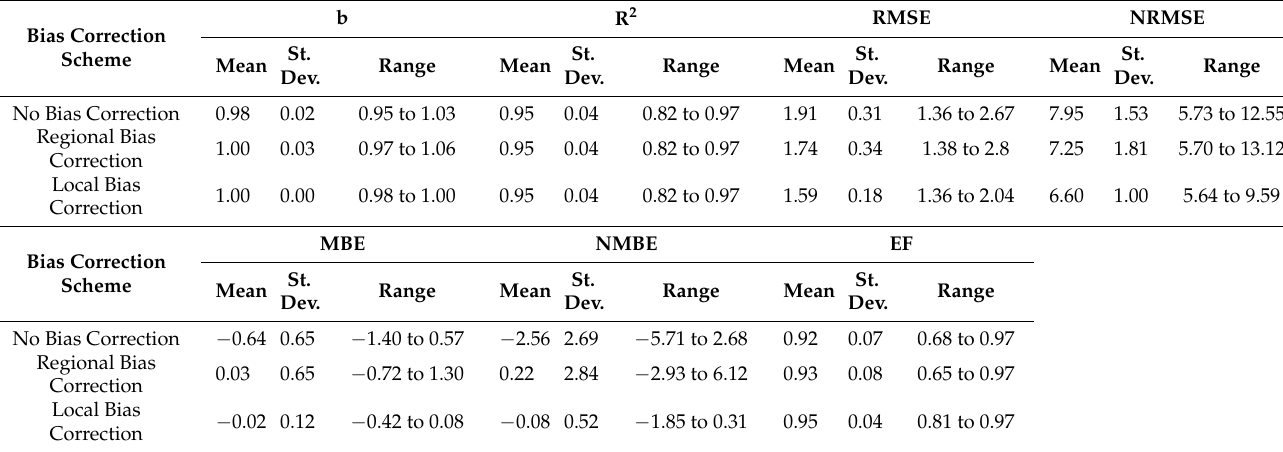
Table 4. Mean and range values of the accuracy metrics relative to NASA POWER maximum temperature with and without bias correction for the full data set of all 14